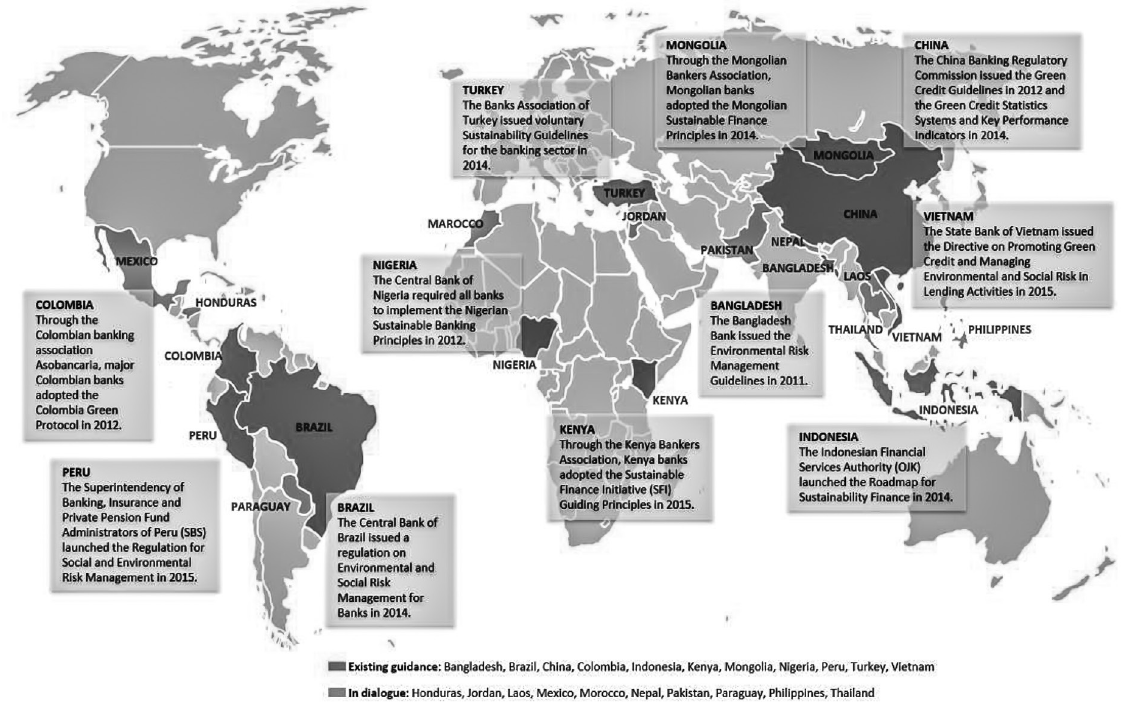
Figure 1. Sustainable Banking Network members and countries having introduced green